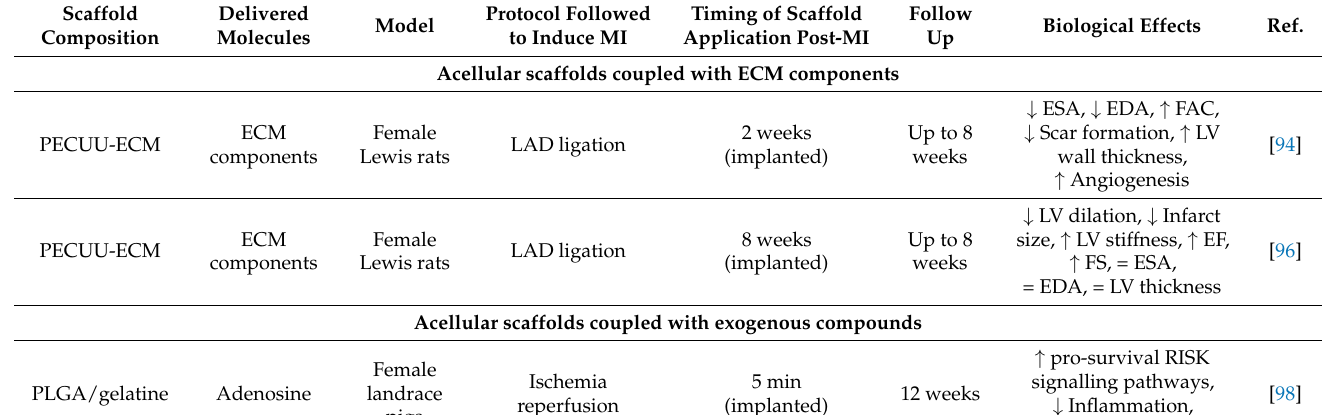
Table 2. Summary of functionalised acellular scaffolds to treat post-MI damage in preclinical models. Scaffold Delivered Composition